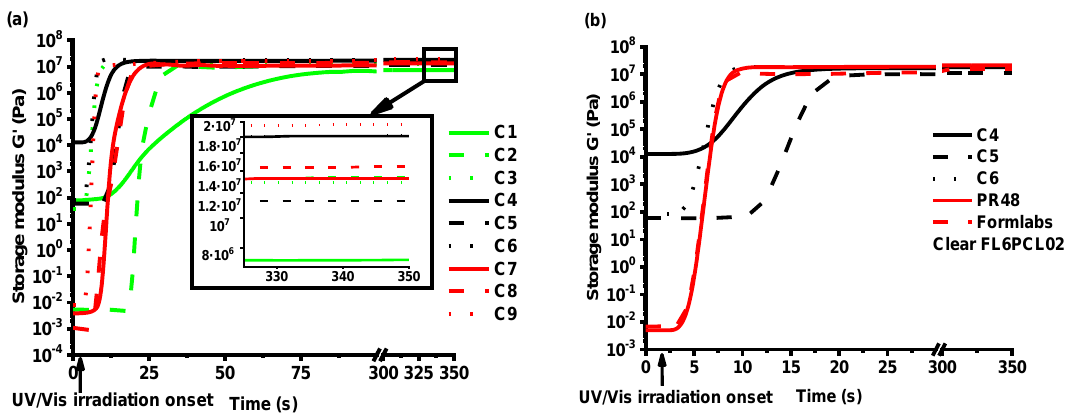
Figure 4. ( a ) Dependencies of storage modulus G’ of the resins C1 – C9 on irradiation time. Concentration of TPOL in the resins: green curves—1 mol.%, black curves—3 mol.%, red curves—5 mol.%. ( b ) Dependencies of storage modulus G’ of the resins C4 – C6, FormLabs Clear FL6PCL02 and PR48 on irradiation time, at 24 °C.